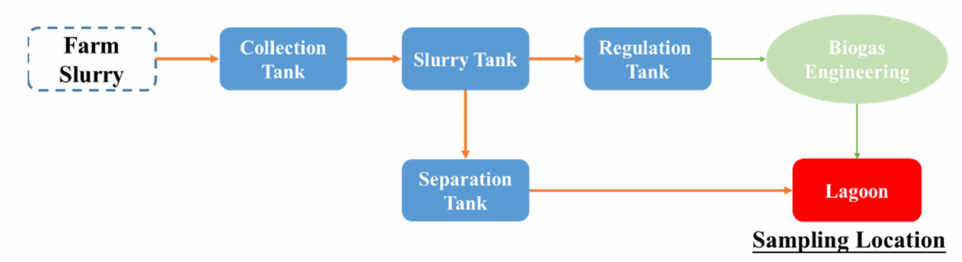
Figure 1. Fecal slurry process flow in three large-scale dairy farms.